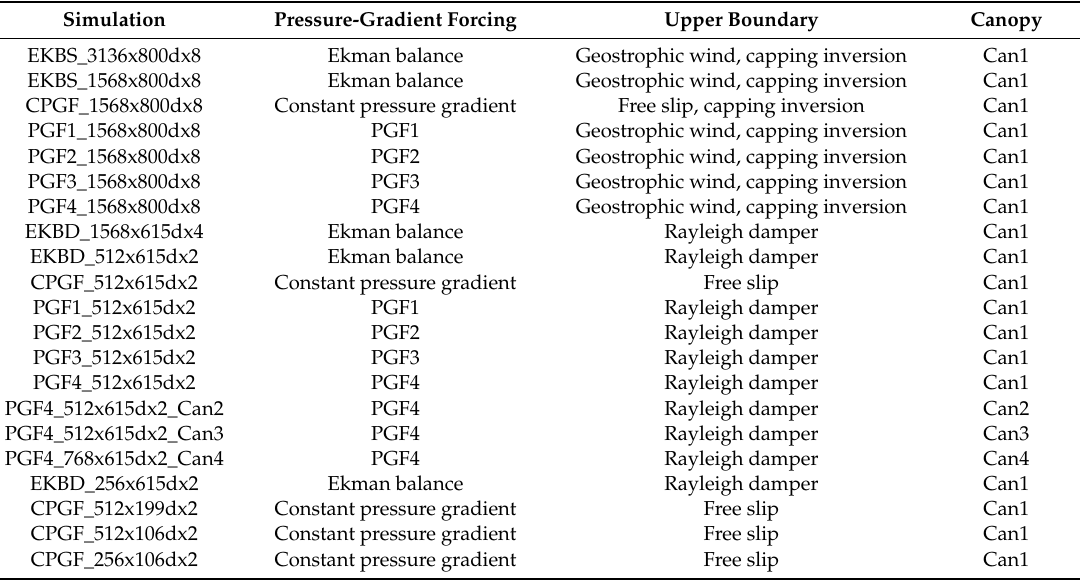
Table 4. Description of the main characteristics of the